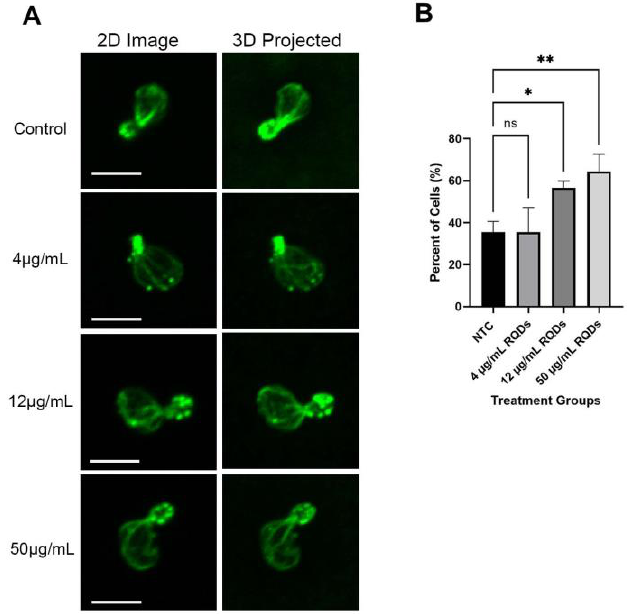
Figure 10. Actin filament integrity assay. ( A ) Cells were treated with an increasing concentration of QDs for 6 h and stained with Actistain 488. Cells were then visualized using the confocal microscope. The left column is a flat, 2D image taken at the mid-plane of cells when cells are in focus. The right columns are the projected pictures from 3D images that allow the visualization of all cables inside yeast cells. Each row signifies images from a treatment group, in the top-down order: control, 4 μ g/mL, 12 μ g/mL, 25 μ g/mL, and 50 μ g/mL. The size bar is equivalent to 5 μ m. ( B ) The percentage of cells with abnormal actin cable was quantified and graphed. A total of 30 cells were used for each sample. * p < 0.05, ** p < 0.01 .